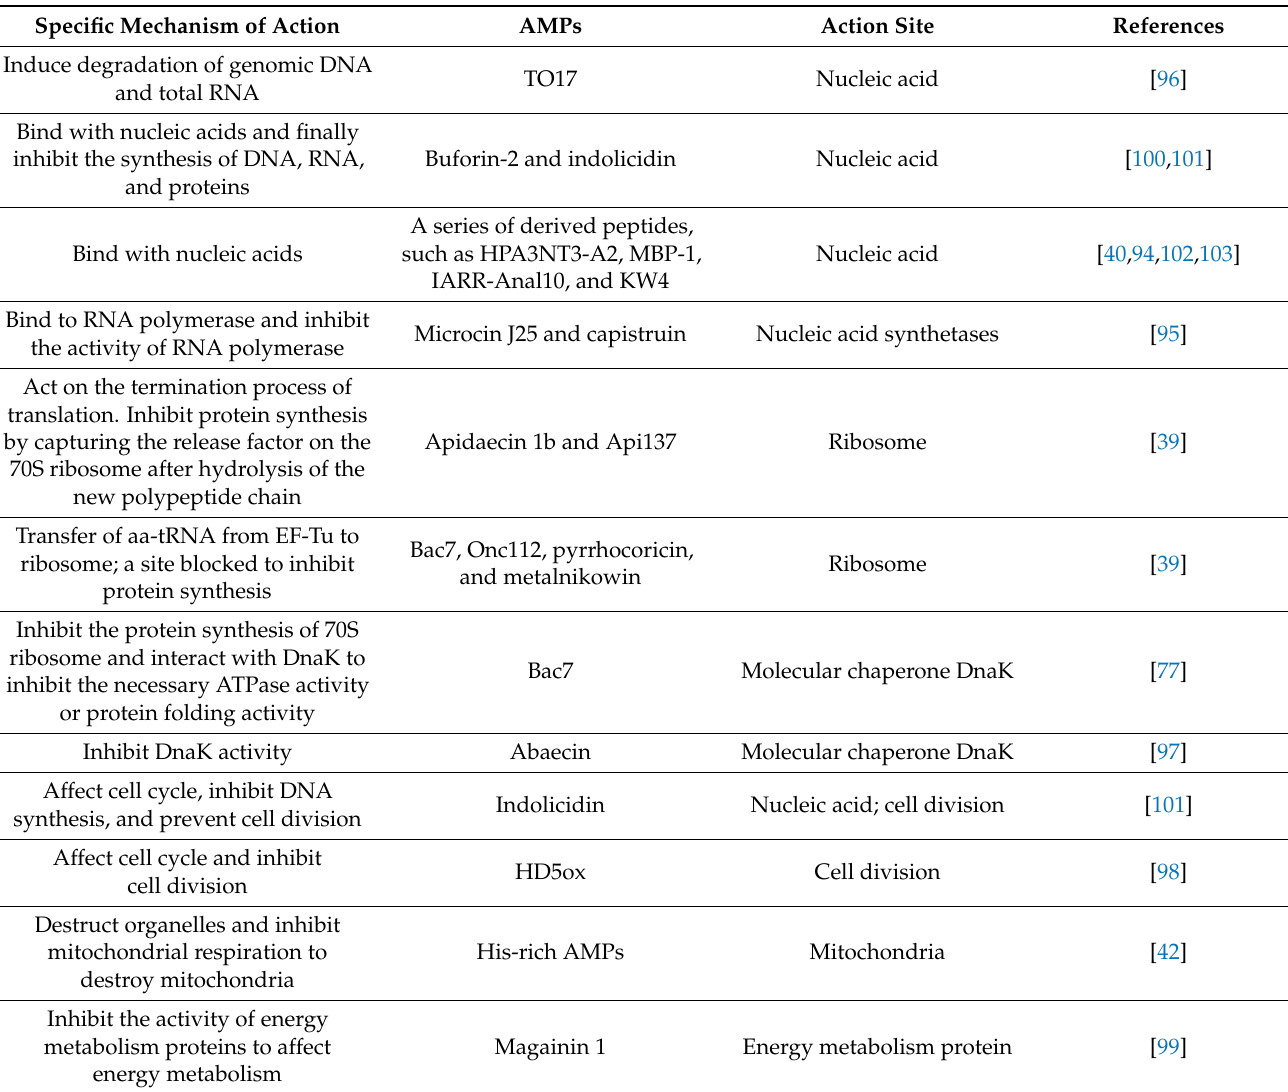
Table 2. Summary of the targets, typical AMPs, and specific action modes of